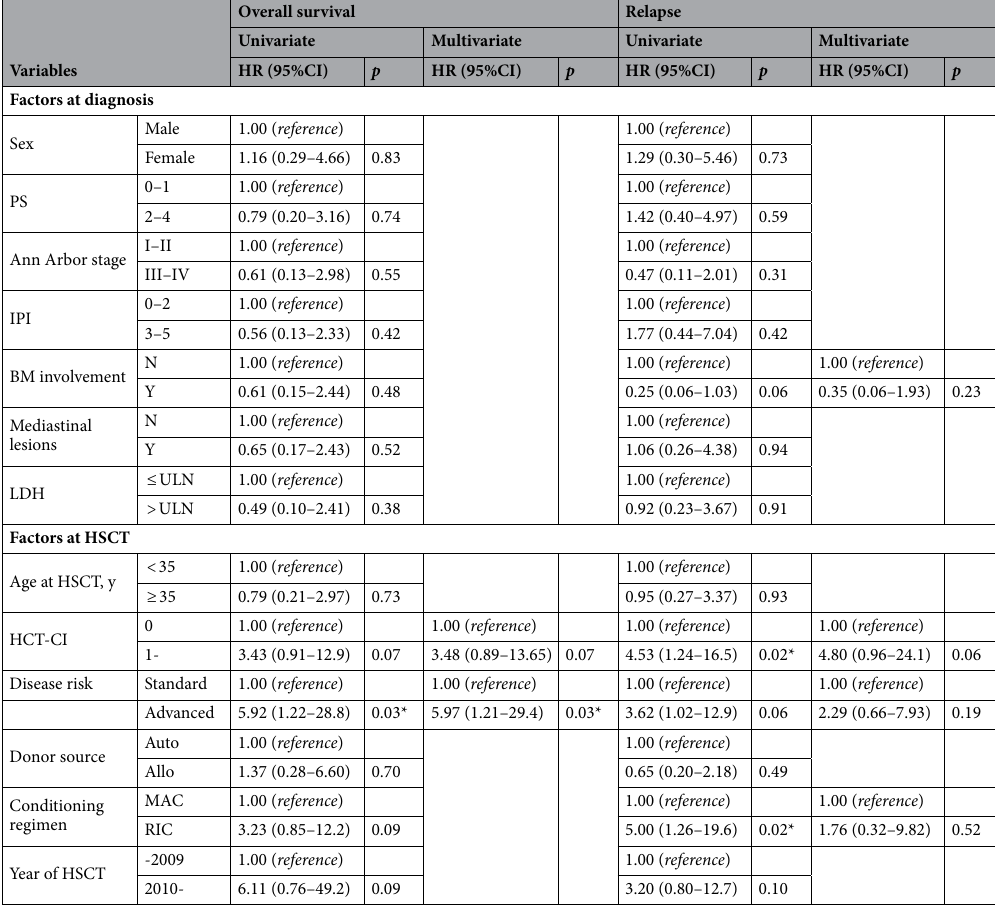
regarding OS following HSCT in the standard-disease group was also confirmed by the analyses assessing OS from the initial diagnosis; the postdiagnosis OS in the entire cohort was 56.3% (95% CI 32.6–74.5%) (Fig. 4A) and was significantly better in the standard-disease group than in the advanced-disease group (79.5%; 95% CI 39.3–94.5% vs. 30.0%; 95% CI 7.1–57.8%; p = 0.02) (Fig. 4B), though a lead-time bias exists, negatively impact- ing standard-disease patients.